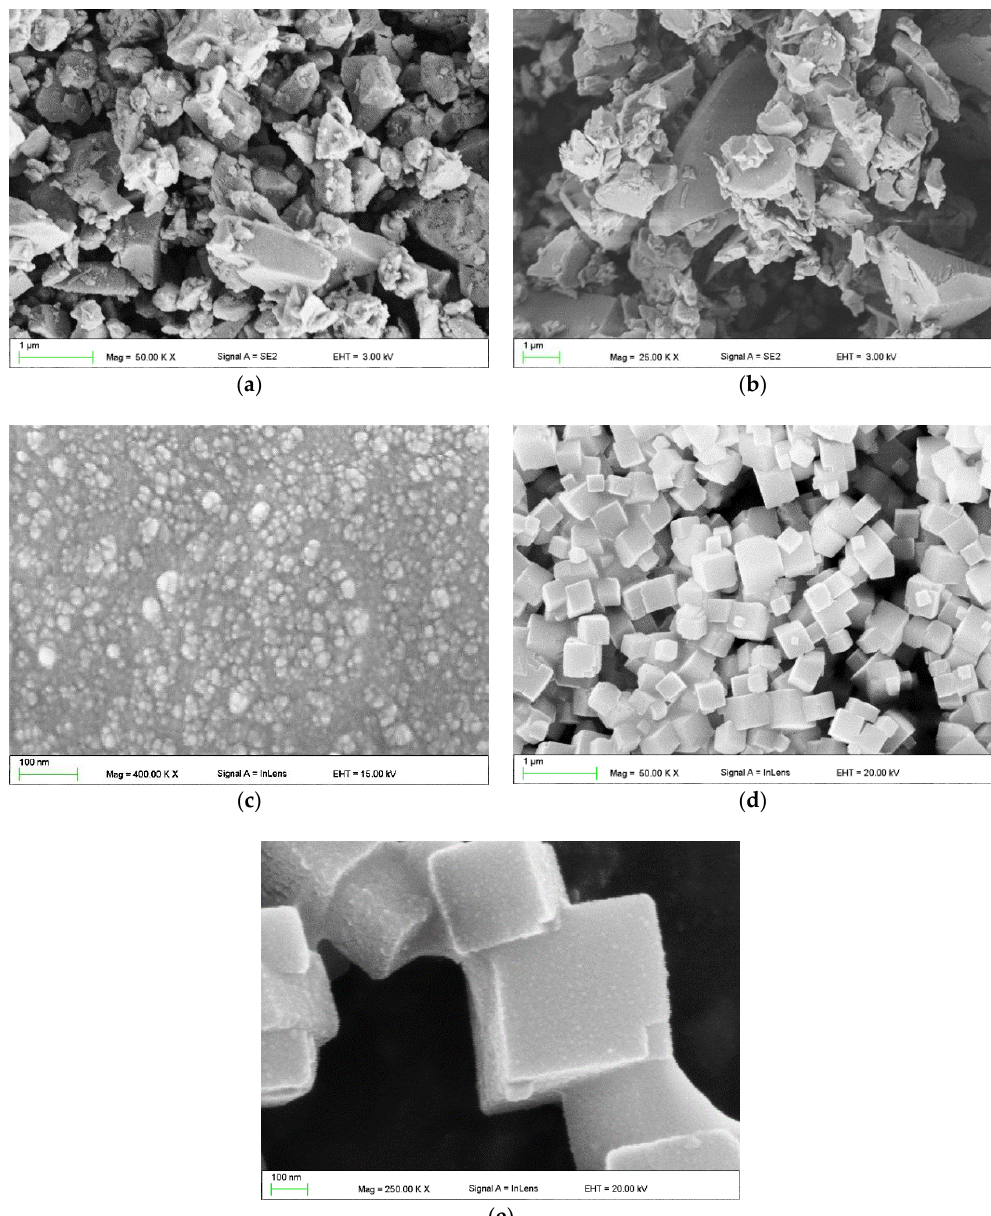
Figure 1. Scanning electron microscopy images presenting the morphologies of used fillers: glass fillers with a mean particle size of 0.7 μm ( a ); 2 μm ( b ); silica nanofiller ( c ); and silver sodium hydrogen zirconium phosphate ( d , e ).